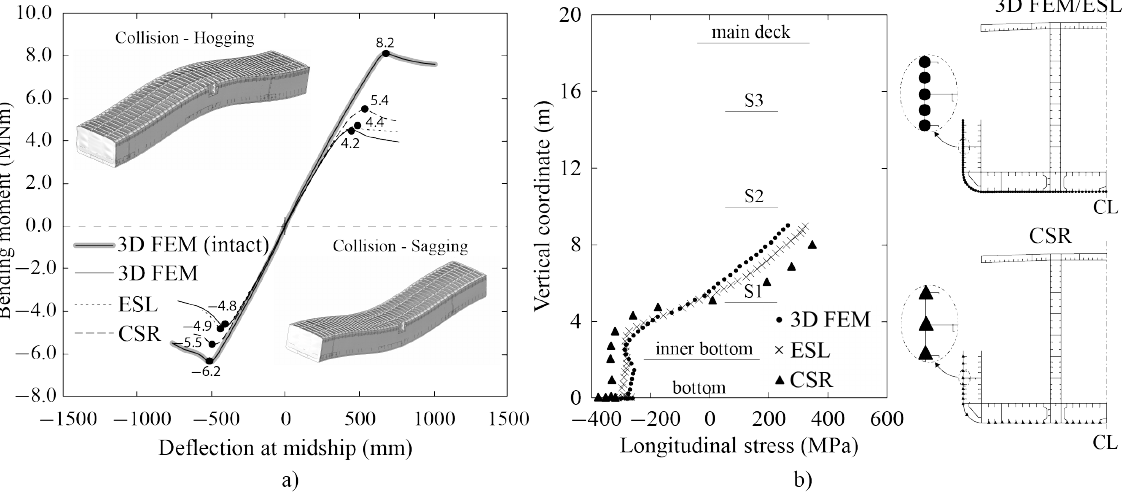
Figure 14. Response of ship collision under vertical bending moment. ( a ) The bending moment– deflection curves. The maximum bending moments are used in calculating the histogram of moment reduction ratio. ( b ) The longitudinal stress distribution to vertical coordinate at the midship under hogging